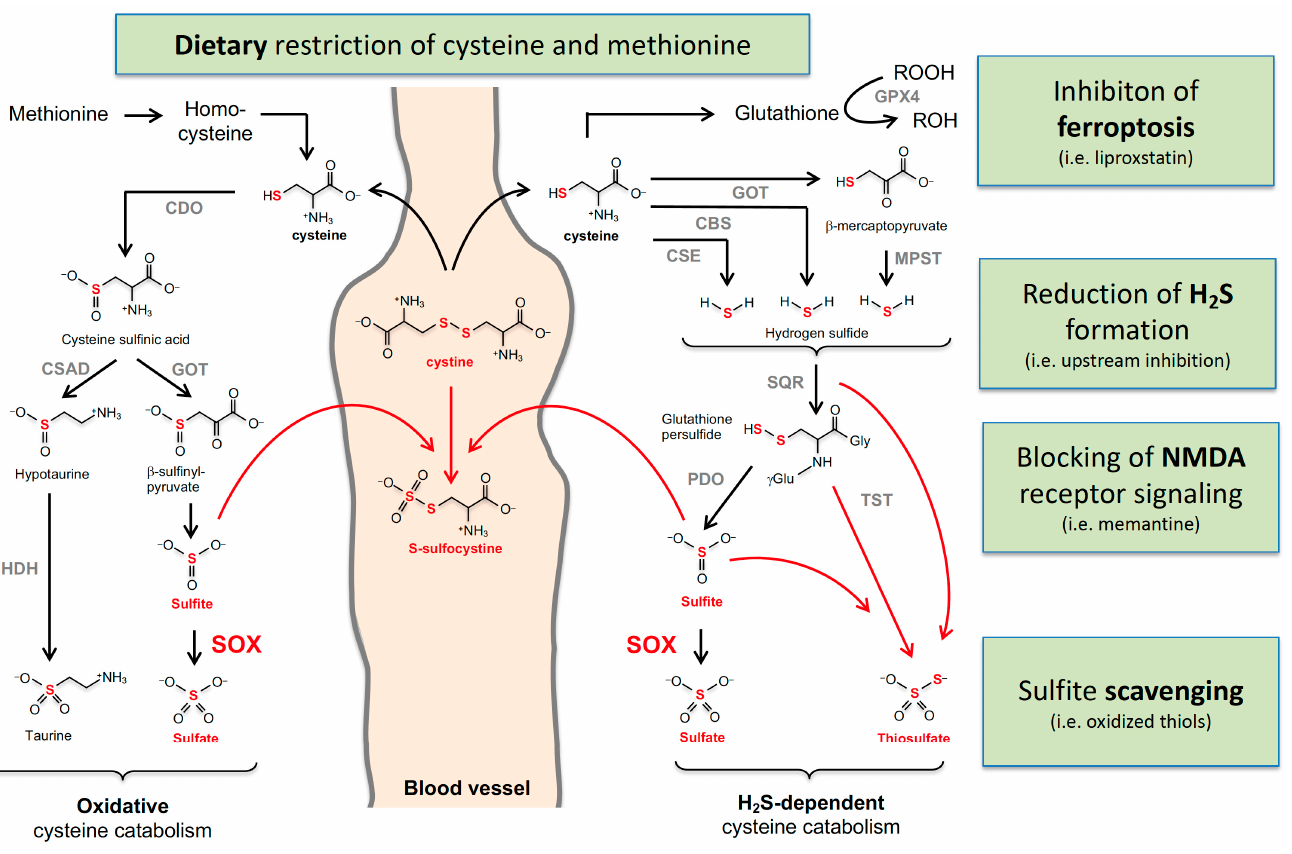
Figure 2. Cysteine catabolism and sulfur-containing metabolites that are altered in MoCD and SOX deficiency. Oxidative and H 2 S-dependent cysteine catabolisms are summarized with the in- volved enzymes and metabolites. Accumulating metabolites in MoCD and SO deficiency are labeled in red. Cystine and homocysteine were found to be reduced. The arrows from methionine to homo- cysteine, cysteine, and glutathione represent multiple enzymatic reactions. Enzyme abbreviations are in alphabetical order: GOT, glutamate oxaloacetate transaminase; CBS, cystathionine β -synthase; CSE, cystathionine γ -lyase; CDO, cysteine dioxygenase; CSD; cysteine sulfinate decarboxylase; HDH, hypoxanthine dehydrogenase; MPST, 3-mercaptopyruvate sulfurtransferase; PSD, per- sulfide dioxygenase; SO, sulfite oxidase; SQR, quinone oxidoreductase; TST, thiosulfate sulfur trans- ferase.